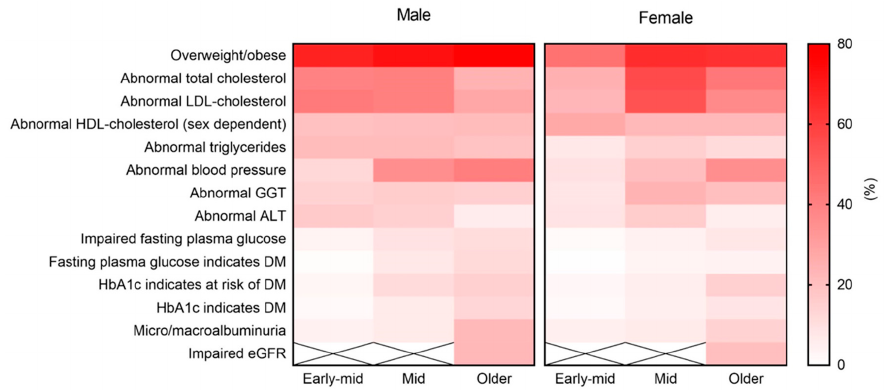
Figure 1. Proportion of Australian males and females meeting lifestyle guidelines, and proportion with lifestyle risk factors. Green panels show the percentage of individuals meeting guidelines (as defined in Table 1) and red panels show the percentage of individuals with specific adverse health behaviours. Abbreviations: SSB, sugar-sweetened beverage.